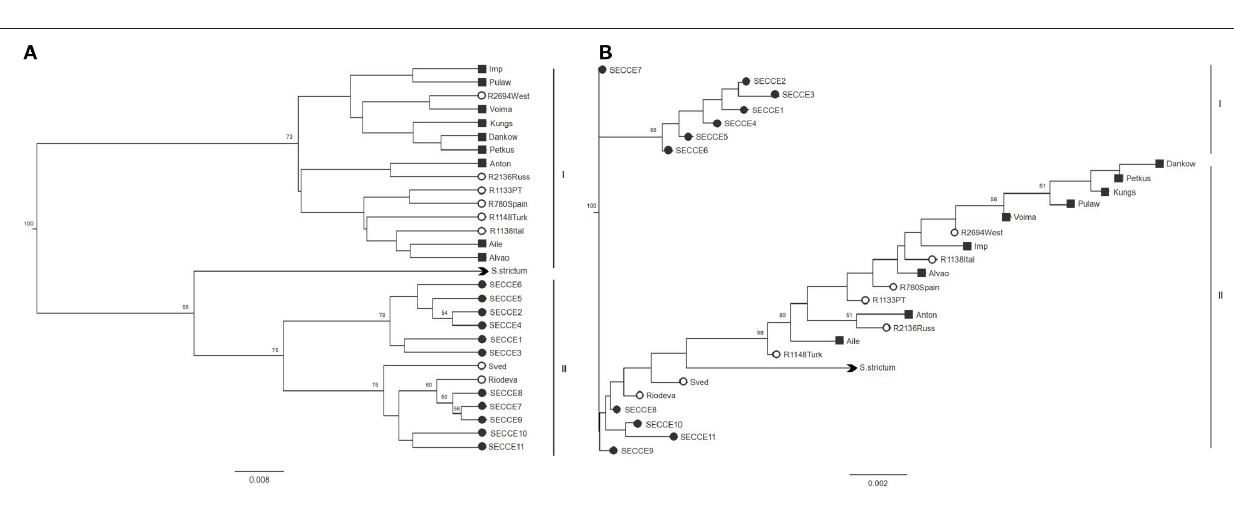
FIGURE 3 | UPGMA (A) and NJ (B) trees generated from Nei’s D distance matrix. Accessions are indicated by symbols reflecting grouping assignment: (cid:4) cultivars, ex situ accessions, in situ accessions. S. strictum was used as a species outgroup ( ). Only bootstraps values above 50 are